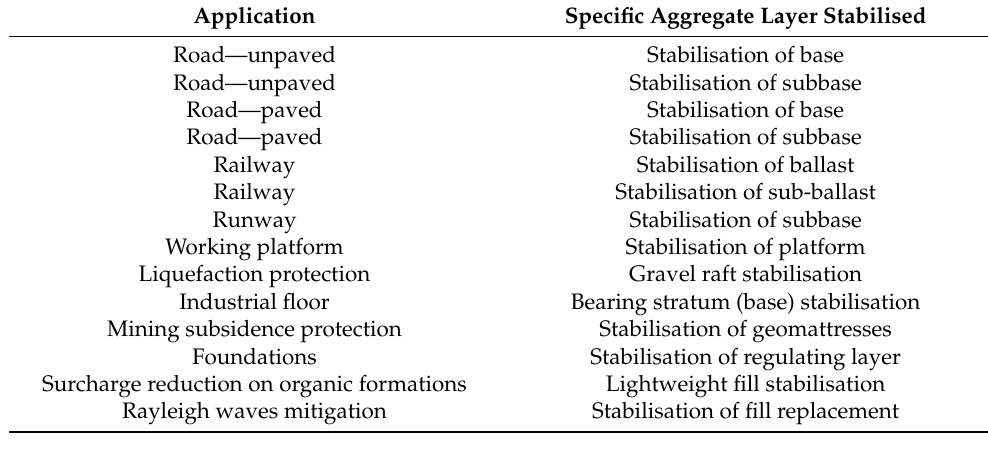
Table 10. List of most popular applications where stabilising geosynthetics provide improvement to performance of aggregate layers.